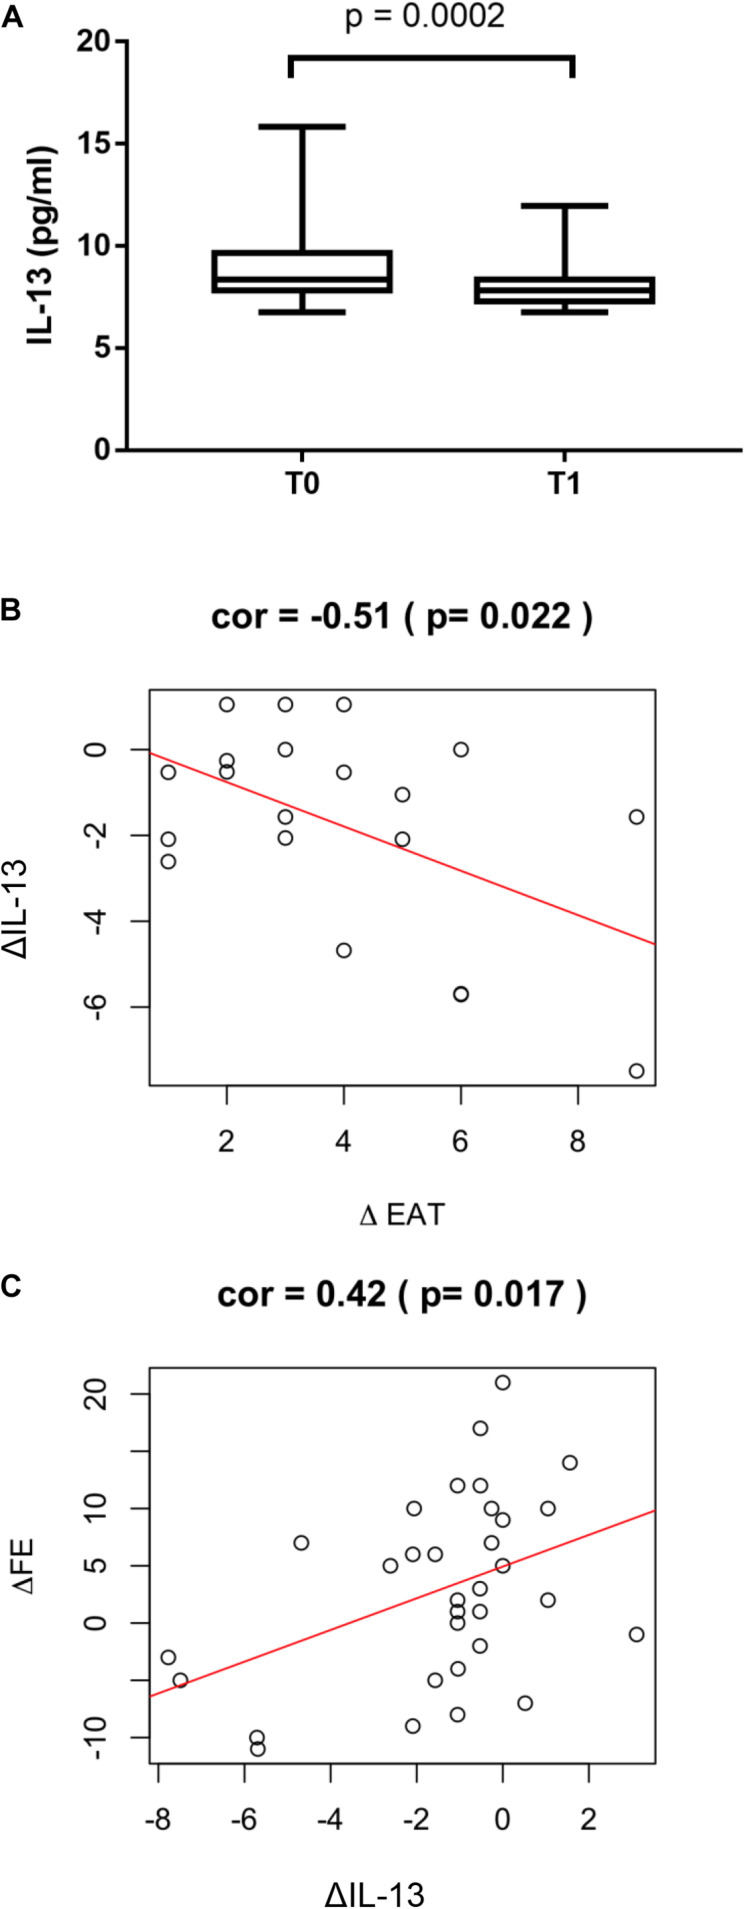
ΔIL-13 and LV remodeling. (A) IL-13 serum levels were measured by using the Bioplex multiplex assay kit as described in section “Materials and Methods”. Values are expressed in pg/ml and their distribution within each group is represented by box plot. Relationship between ΔIL-13 and (B) ΔEAT (r = −0.51; p = 0.022) and (C) ΔLVEF (r = 0.42; p = 0.017) was assessed using the Pearson correlation coefficient.